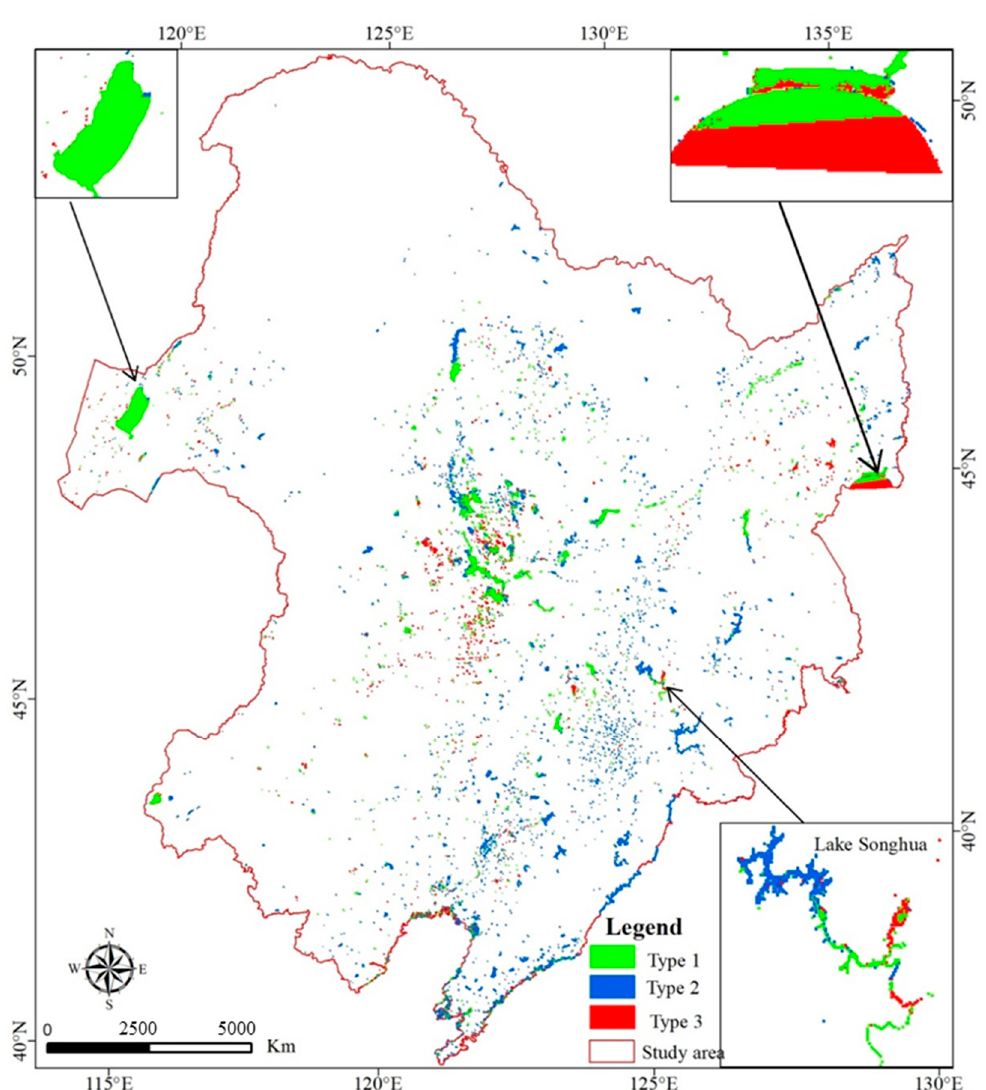
Figure 9. Spatial pattern of optical water types in the study area.